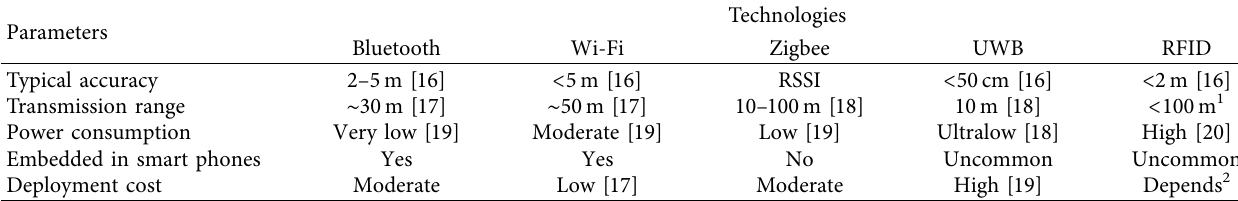
Table 1: Te characteristics of IPS underlying